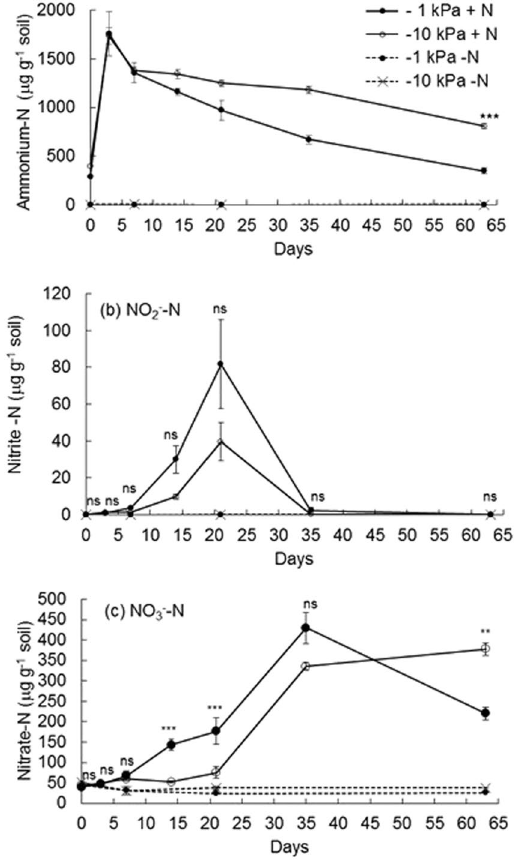
Figure 4. Changes in soil inorganic-N over time. Concentrations of extractable ( a ) ammonium-N ( b ) nitrite-N and ( c ) nitrate-N under near saturated ( − 1 kPa) or field capacity ( − 10 kPa) soil moisture conditions, following urea application ( + N) or nil urea application ( − N). Symbols are means (n = 4) with vertical error bars the standard error of the mean. Asterisks * , ** , *** indicate significant differences between moisture treatments under urea treatments at P < 0.05, P < 0.01, and P < 0.001, respectively.